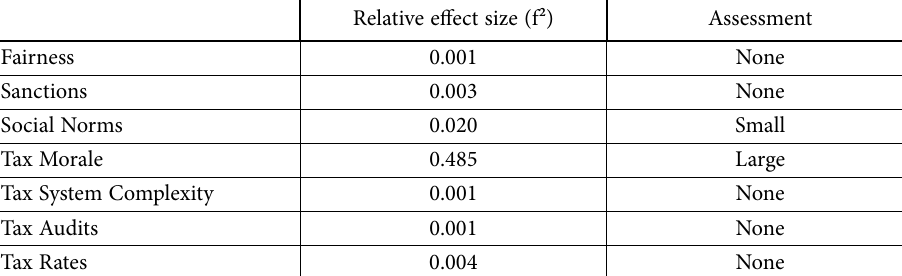
Table 7. Relative effect